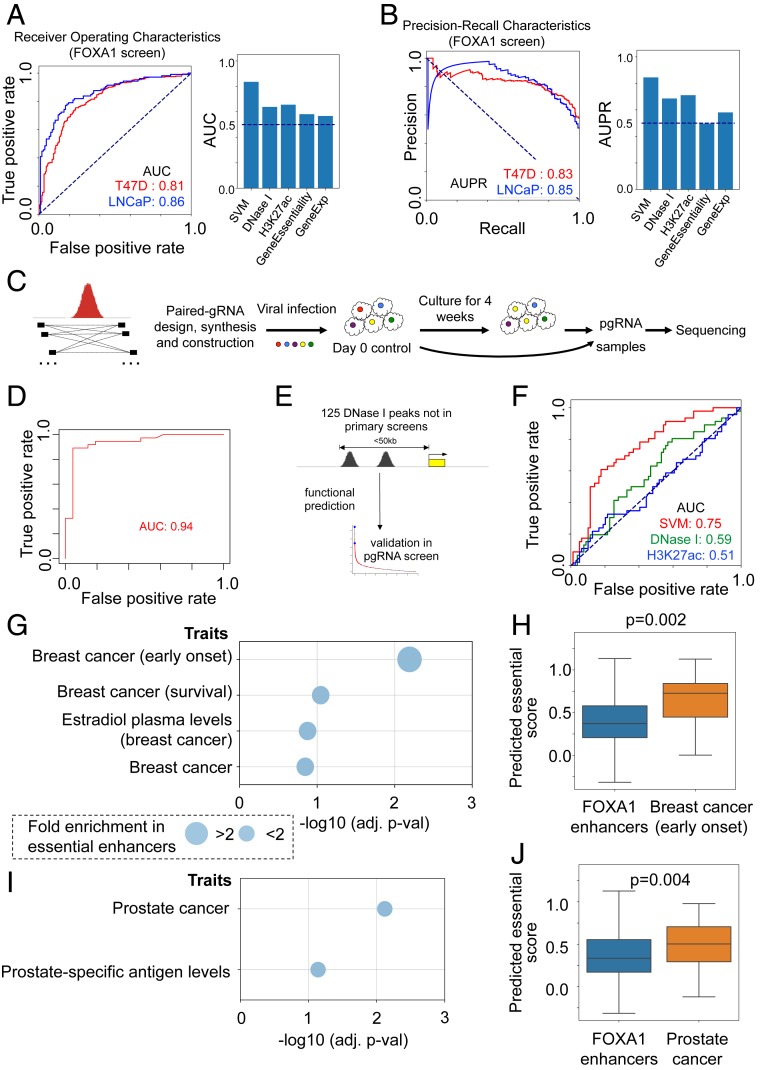
Predicting and validating essential enhancers. (A) The receiver operator characteristic (ROC) curves of different approaches for predicting FOXA1 binding site essentialities using different combinations of features. The AUC values using the SVM and individual features are also shown. (B) The precision-recall characteristic (PR) curves of A. The area under the PR curve (AUPR) of different approaches is shown. (C) An overview of the design of the pgRNA library and the screening strategy. Up to 25 pgRNAs are designed to knock out each binding site. (D) The ROC curve of the primary screening results in pgRNA screens. (E) The validation procedure of the prediction model using 125 DNase I binding sites that are not included in the sgRNA screening library. (F) The ROC curve of the prediction model (and 2 single features) in predicting the functions of 125 DNase I binding sites. (G) The enrichment of breast cancer-related variants over essential enhancers in T47D cells. The adjusted P values (using the χ2 test) are shown. Circle sizes indicate the fold enrichment over essential enhancers (>2 or <2). (H) The predicted score distribution of all FOXA1-bounded enhancers, and enhancers that carry variants of “breast cancer (early onset).” The P value is calculated using the Wilcoxon rank-sum test. (I and J) The same analysis of G and H in LNCaP cells.